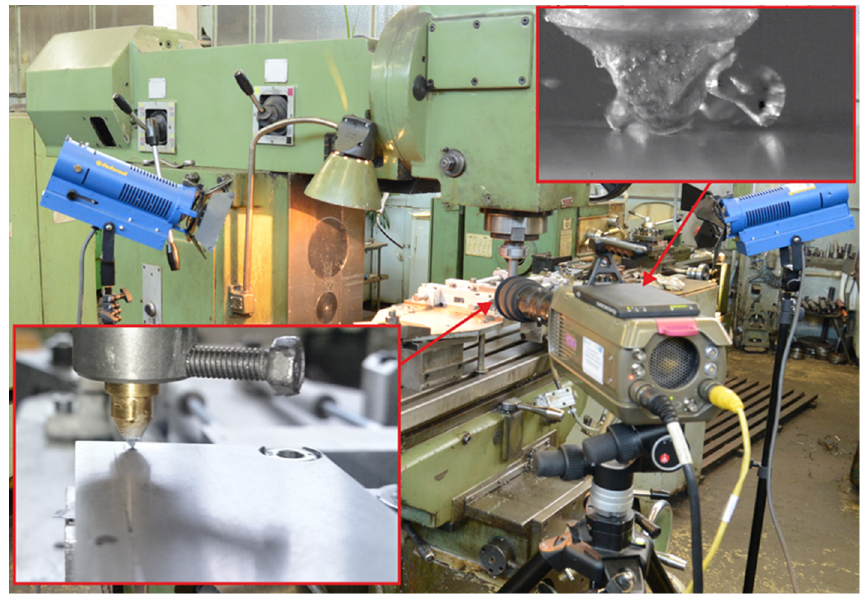
Figure 4. Test stand for scratch tests.